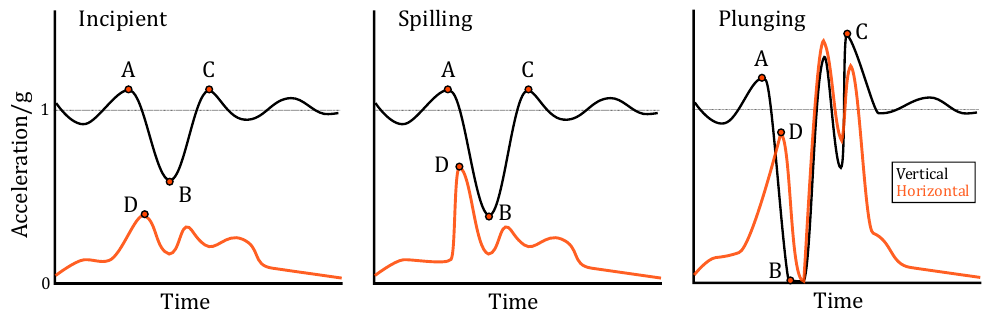
Figure 9. Approximate representations of the acceleration signature produced by incipient, spilling, and plunging breakers. Four points were used to quantify the acceleration magnitudes generated by the different breaker types. Point A is the maximum vertical heave acceleration generated as the wave approaches, while point B is the minimum vertical acceleration reached as the buoy reaches the wave crest. Point C, in the case of incipient and spilling waves, is the maximum vertical acceleration of the buoy as it falls back into the wash behind the wave, or in the case of plunging, lands in the water forward of the wave and tumbles in the barrel. Point D is the maximum horizontal acceleration generated by the initial impact of the wave.